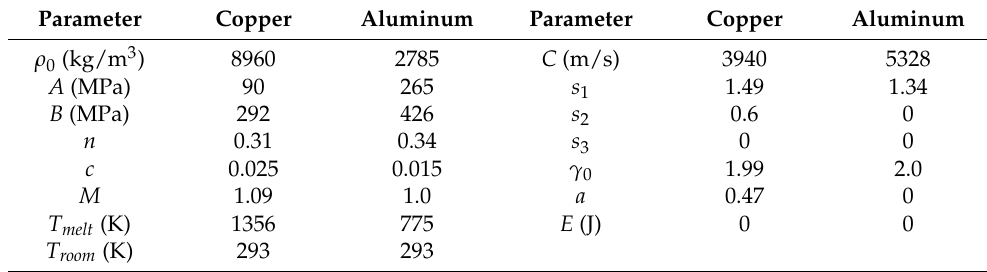
Table 4. Metal material model and parameters